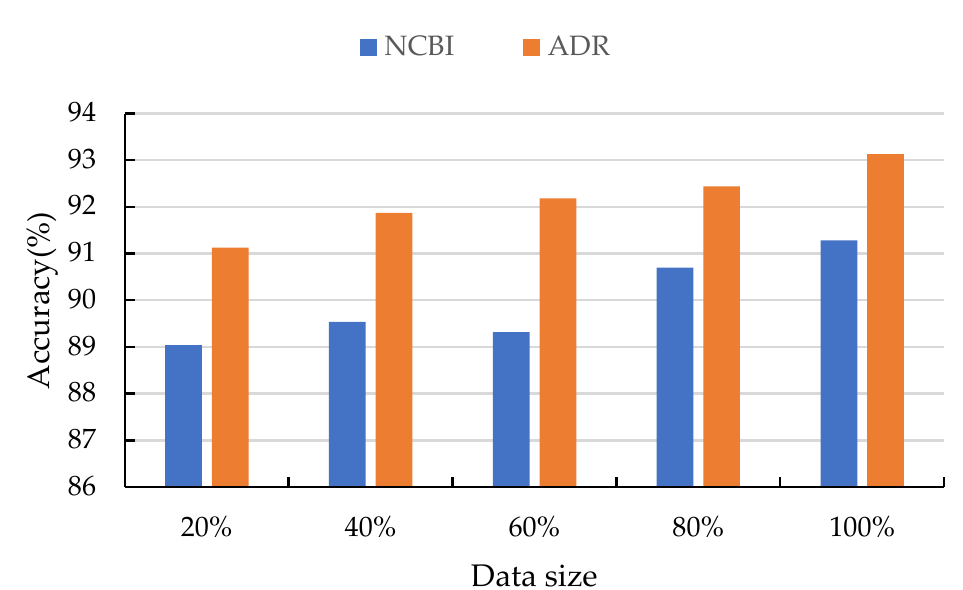
Figure 5. Effects of different data sizes on performance of our model.